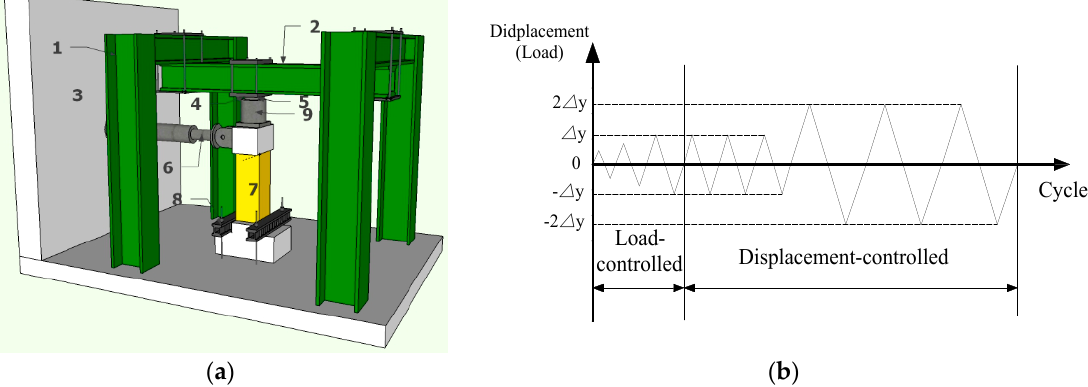
Figure 4. ( a ) Test set up (1. Reaction steel frame; 2. Reaction steel beam; 3. Reaction wall; 4. Spherical